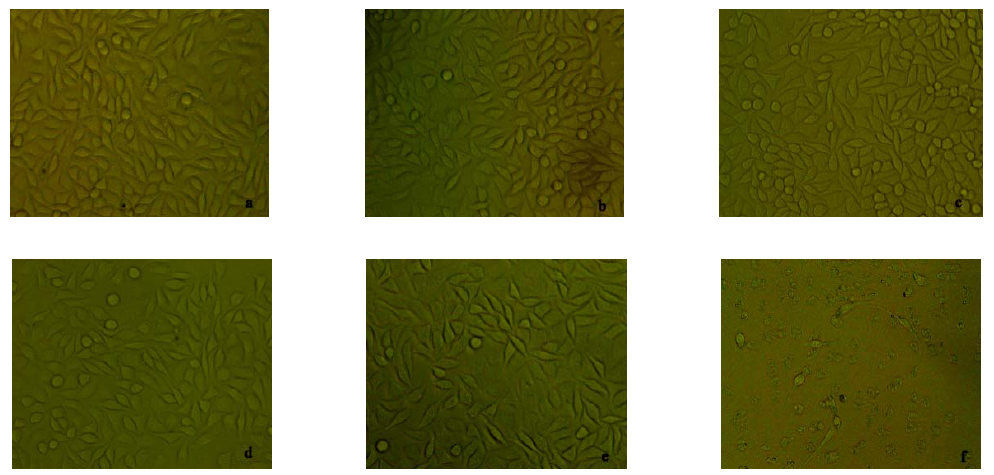
Zn Fe O nanoparticles evaluated by MTT 0.5 0.5 2 4